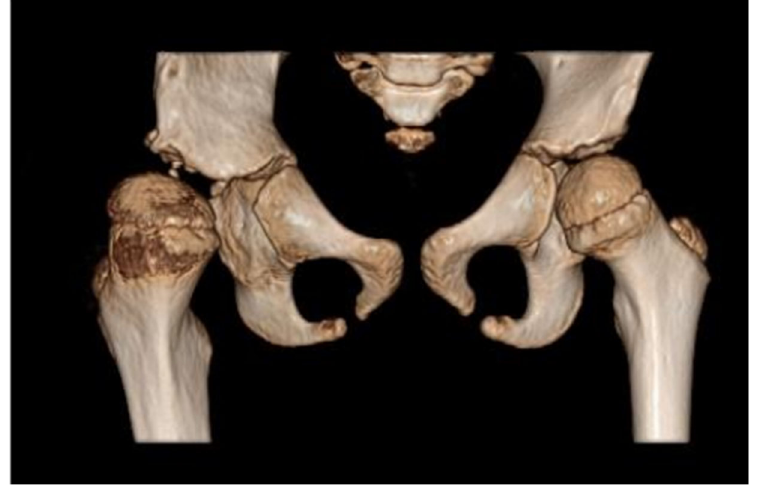
Figure 4. Computed tomography (CT) of the pelvis—3D scan carried out at 5 years of age. The relative tilt angle of the femoral head is about 47°; the angle of internal rotation is about 25°. Knee set in internal rotation. Femoral head in anterolateral subluxation. Joint space significantly widened. Thickening of soft tissues around the hip joint; exudate cannot be excluded. Differentiation reveals postoperative changes and inflammation. The acetabulum is slightly distorted in the area of the roof and flattened with irregular contours, marginal sclerotization, and small defects. A ~4 mm calcification or ossification can be seen in the soft tissues in front of the anterior part of the acetabular roof and below the posterior edge of the roof. The femoral head is flattened. There is marked thinning of the bone structure of the femoral head and neck.